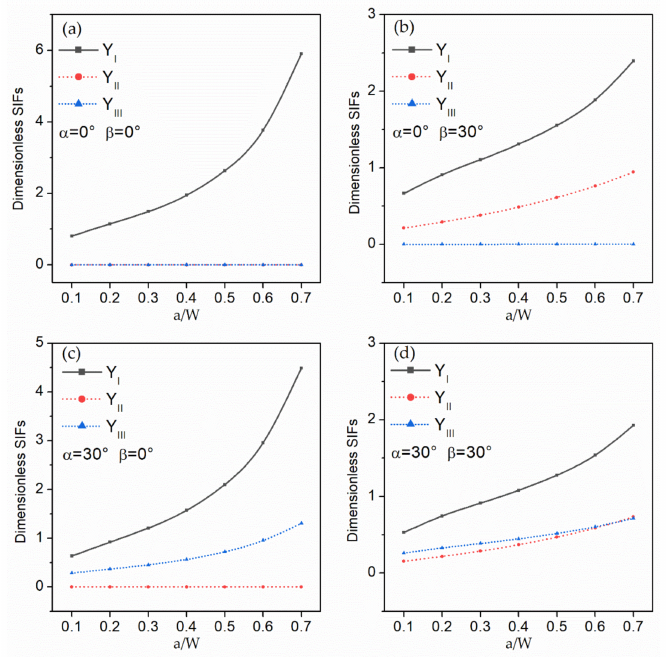
Figure 4. The relationship between dimensionless SIFs and crack height ratio a/W for typical crack inclined angles. ( a ) The normalized SIFs in α = 0 ◦ and β = 0 ◦ . ( b ) The normalized SIFs in α = 0 ◦ and β = 30 ◦ . ( c ) The normalized SIFs in α = 30 ◦ and β = 0 ◦ . ( d ) The normalized SIFs in α = 30 ◦ and β = 30 ◦